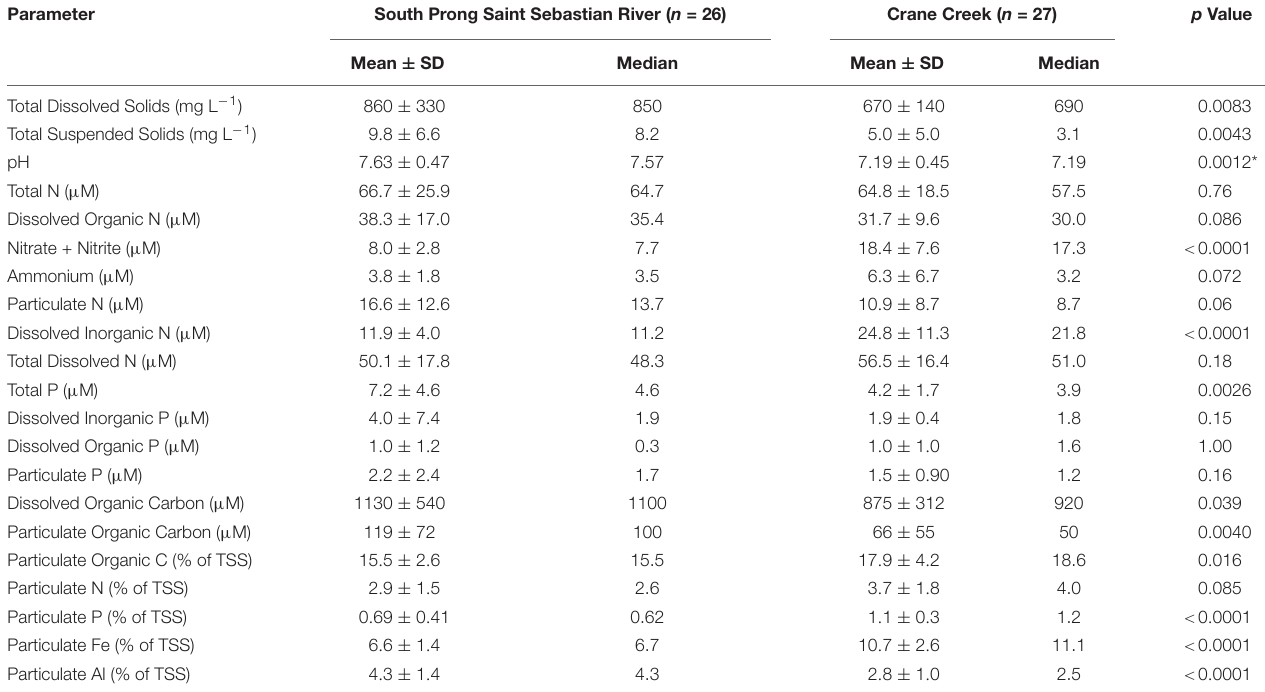
TABLE 1 | Means ± standard deviations (SD) and medians for concentrations of chemicals during monthly surveys, December 2015–March 2018.